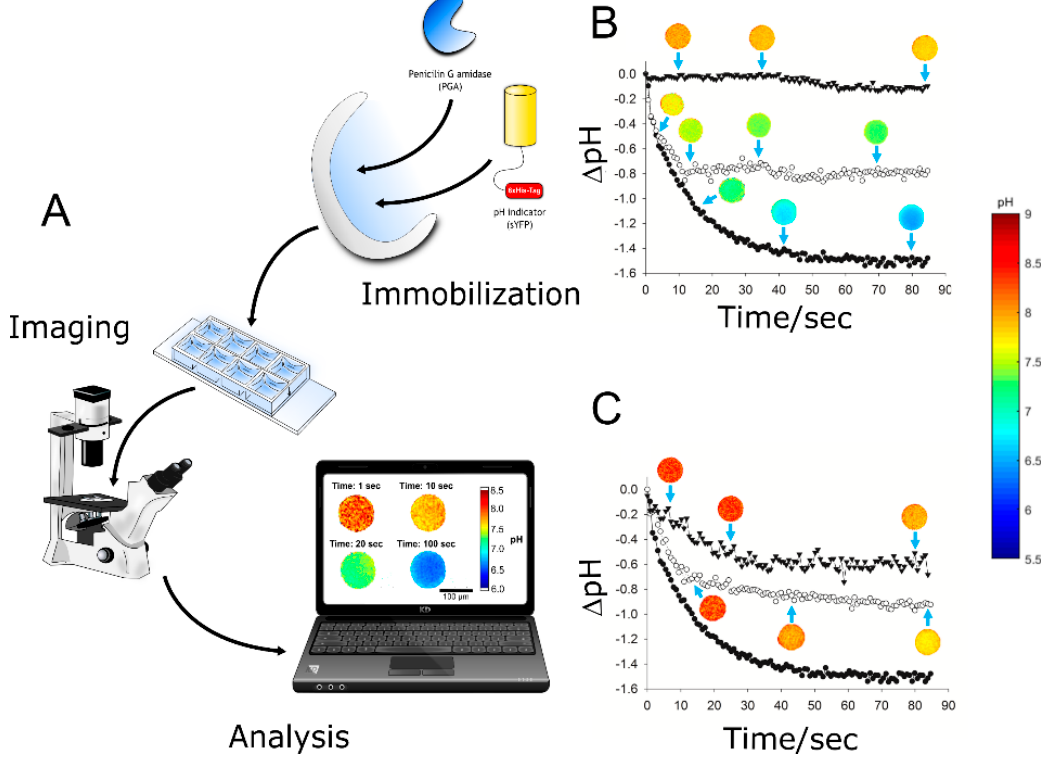
Figure 10. Measurement of intraparticle pH by sYFP-immobilized fluorescent protein. Panel ( A ) shows the set-up of the measurement. ( B , C ) show the evolution of Δ pH (internal pH – bulk pH) in reaction time courses of different enzyme catalysts. Panel ( B) shows the effect of the penicillin acylase loading (per gram of carrier): 805 U ( ● ), 130 U ( ○ ) and 27 U ( ▼ ). Panel ( C ) shows the effect of the sodium phosphate buffer concentration: 10 mM ( ● ), 100 mM ( ○ ) and 200 mM ( ▼ ). The penicillin acylase loading used 805 U g –1 of carrier, and 20 mM penicillin G was used. Images of catalyst particles corresponding to each reaction are shown for different time points (blue arrows). Adapted with permission from reference [67]. Copyright (2018) American Chemical Society.